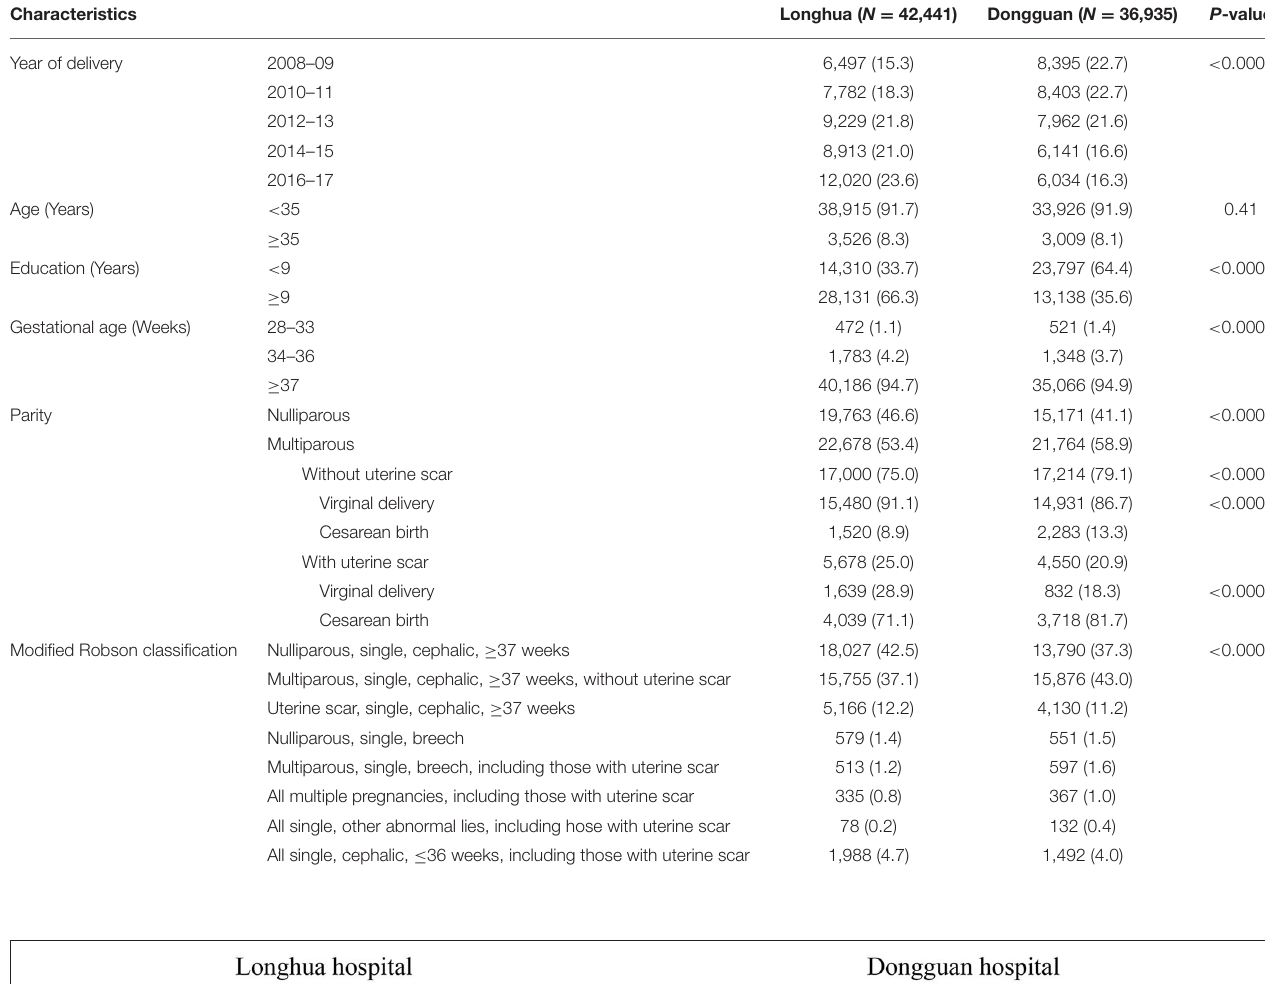
TABLE 2 | Demographical and clinical characteristics of women delivering babies in 2008–2017 in two hospitals in Guangdong, China. Characteristics